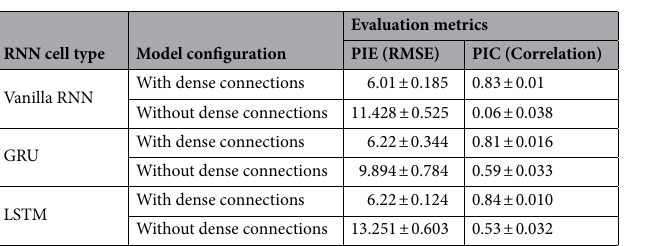
Table 4. Performance comparison between densely connected RNN models and plain RNN